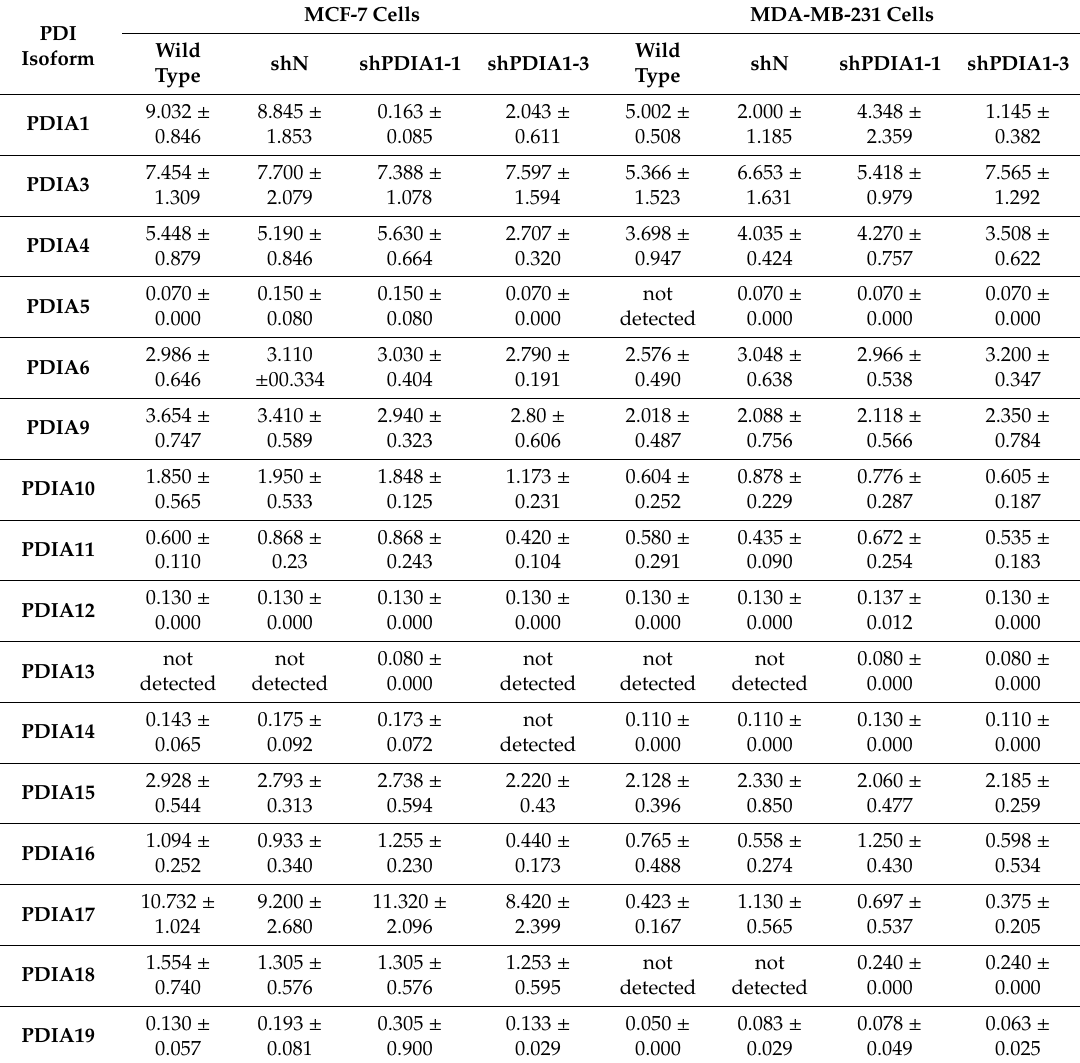
Table 2. Relative content of PDIs (emPAI) in MCF-7 and MDA-MB-231 cell lines after PDIA1